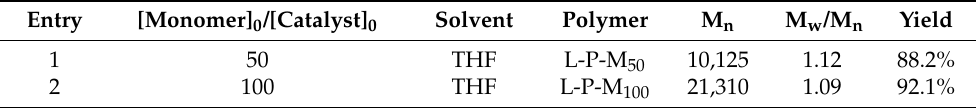
Table 1. Polymerization results of L-P-M n with palladium catalyst as initiator at 55 ◦